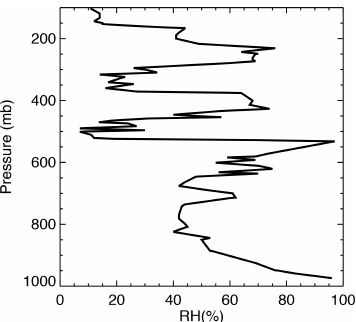
Figure 4. Radiosonde-observed vertical profile of relative humidity from Springfield, MO (at 37 ◦ 14 (cid:48) N, 93 ◦ 24 (cid:48) W), the nearest station to the Columbia site, at 12:00UTC on 21 August 2017 obtained from http://weather.uwyo.edu/upperair/sounding.html (last access: 21 August